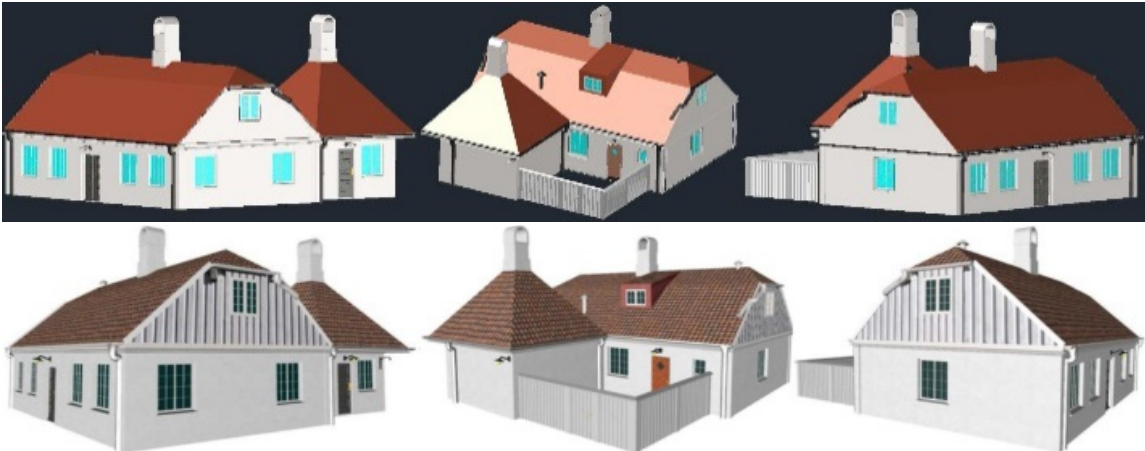
Figure 5: Commander’s Residence of fortification Kristiansten – Constructed 3D CAD model from photogrammetric images (top) and 3D model textured in Cinema 4D